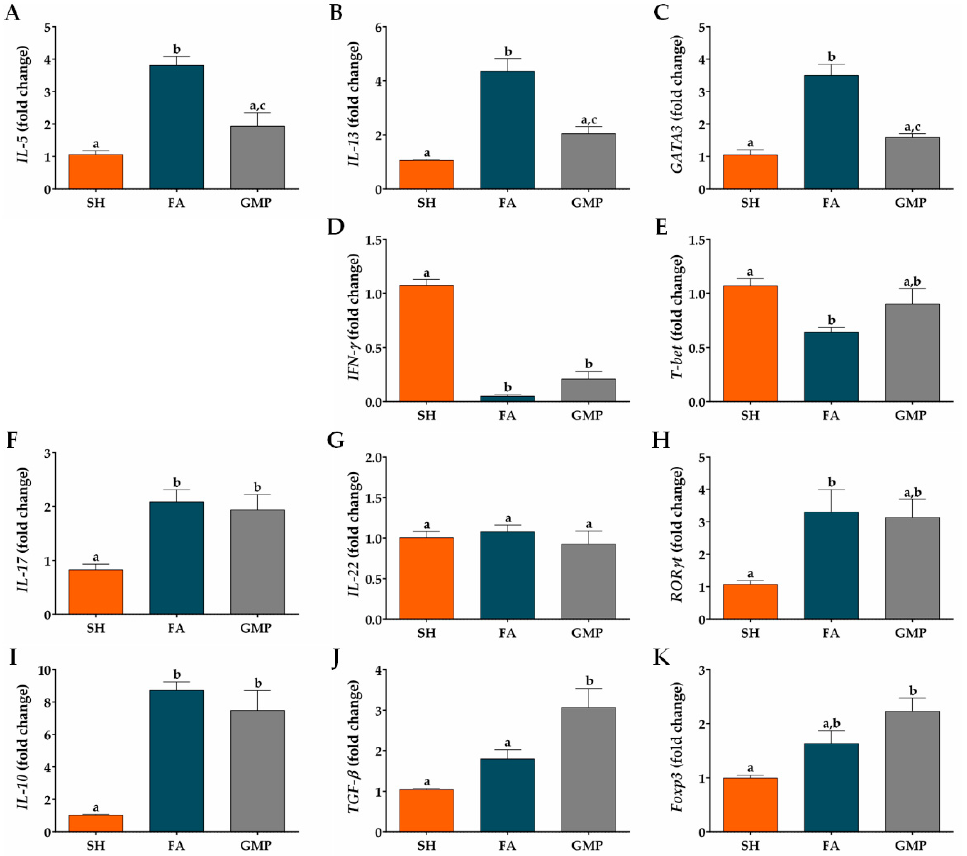
Figure 8. Effect of treatment with glycomacropeptide (GMP) on intestinal expression level of cytokines and transcription factors. Intestinal expression level of: cytokines ( A ) IL-5 and ( B ) IL-13 and transcription factor ( C ) GATA3 , characteristics of type 2 immune response; cytokine ( D ) IFN- γ and transcription factor ( E ) T-bet , distinctives of type 1 immune response; cytokines ( F ) IL-17 and ( G ) IL-22 and transcription factor ( H ) ROR γ t , involved in type 17 immune response; cytokines ( I ) IL-10 and ( J ) TGF- β and transcription factor master ( K ) Foxp3 , inductors of regulatory immune response. Expression level of all cytokines and transcription factors relative to β -actin was analyzed by quantitative PCR and expressed as fold change ( n = 4). SH, sham control; FA, FA-induced; GMP, FA-induced and GMP-treated animals. Different letters (a,b,c) indicate statistical difference.